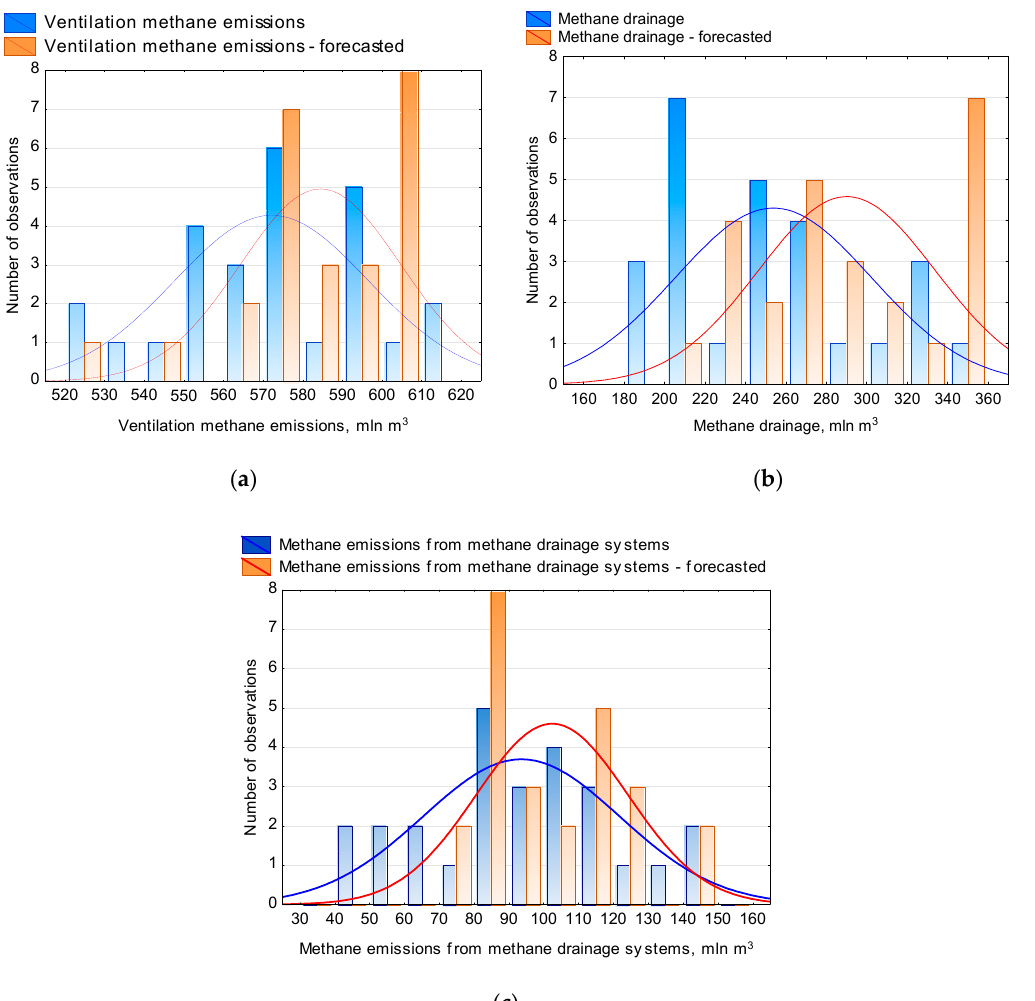
Figure 21. Histograms of the actual and the predicted values of ventilation methane emissions into the atmosphere ( a ), the amount of methane drainage ( b ), and methane emissions from methane drainage systems into the atmosphere ( c ).